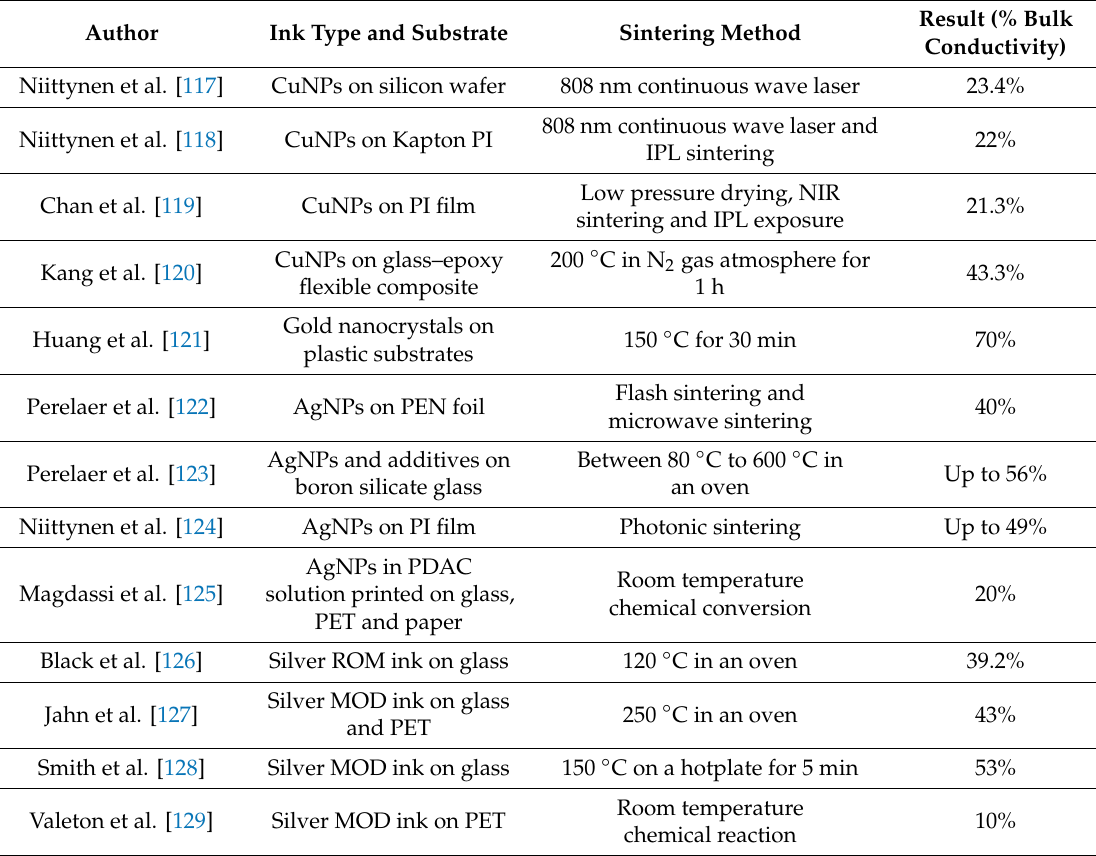
Table 2. A summary of some of the best experiments using high-performance inks and their sintering methods, with state-of-the-art results obtained. Abbreviations: reactive organometallic inks, ROM; metal − organic decomposition, MOD; intense pulsed light, IPL; near-infrared, NIR; poly(diallyldimethylammonium chloride),